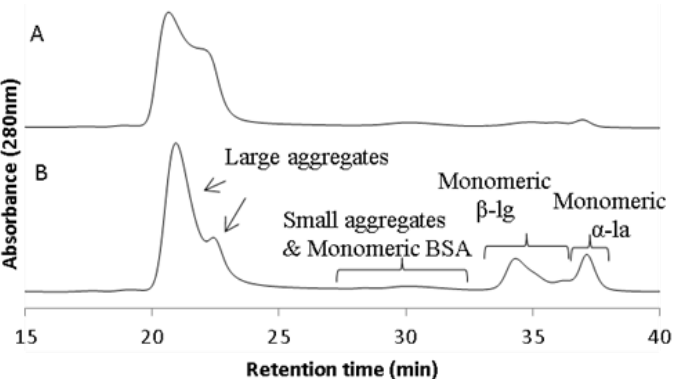
Figure 2. Size exclusion chromatograms (SEC-HPLC) of ( A ) high-heat-treated infant milk formula (HT-IMF) and ( B ) membrane-filtered infant milk formula (MEM-IMF).